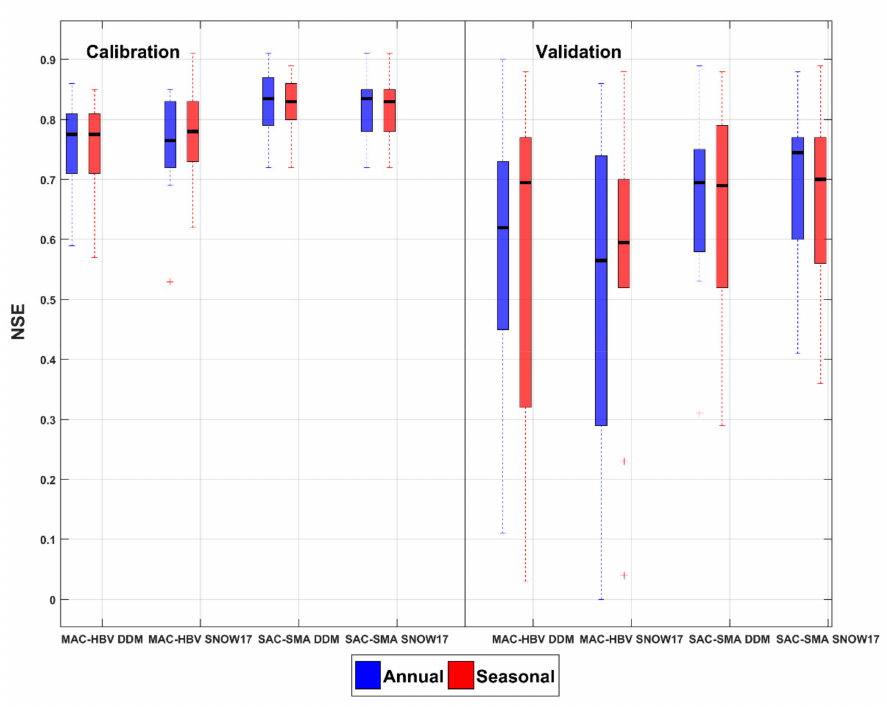
Figure 5. NSE statistics for MAC-HBV-DDM, MAC-HBV-SNOW-17, SAC-SMA-DDM, SAC-SMA- SNOW-17 model structures for annual and seasonal models of LGRB. Boxplot description same as Figure 3, except the median is marked with a thick black line inside boxes.